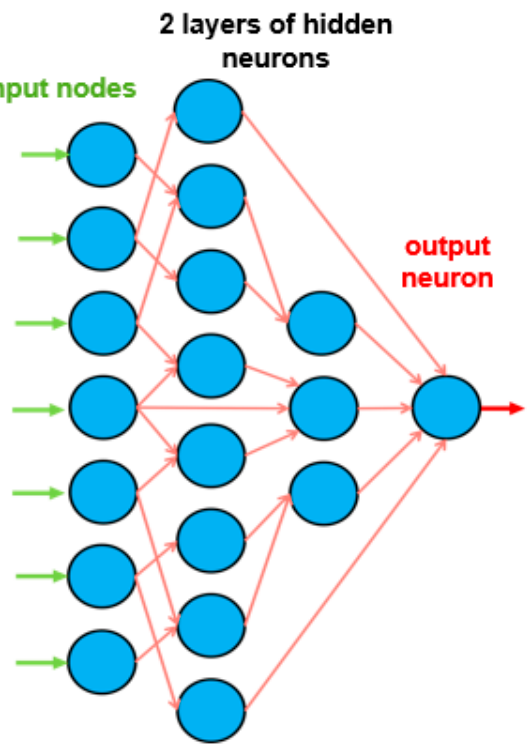
Figure 1. Example of feedforward neural network.